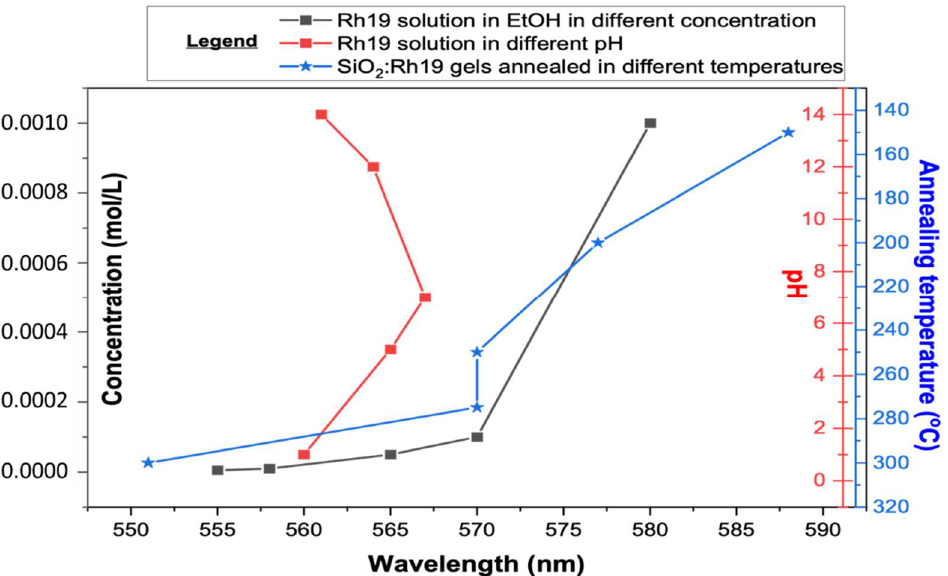
Figure 2. The relationship between pH and concentration compared to the results obtained with the gels for Rhodamine 19 (Rh 19)-doped materials (abbreviations used: EtOH—ethanol).